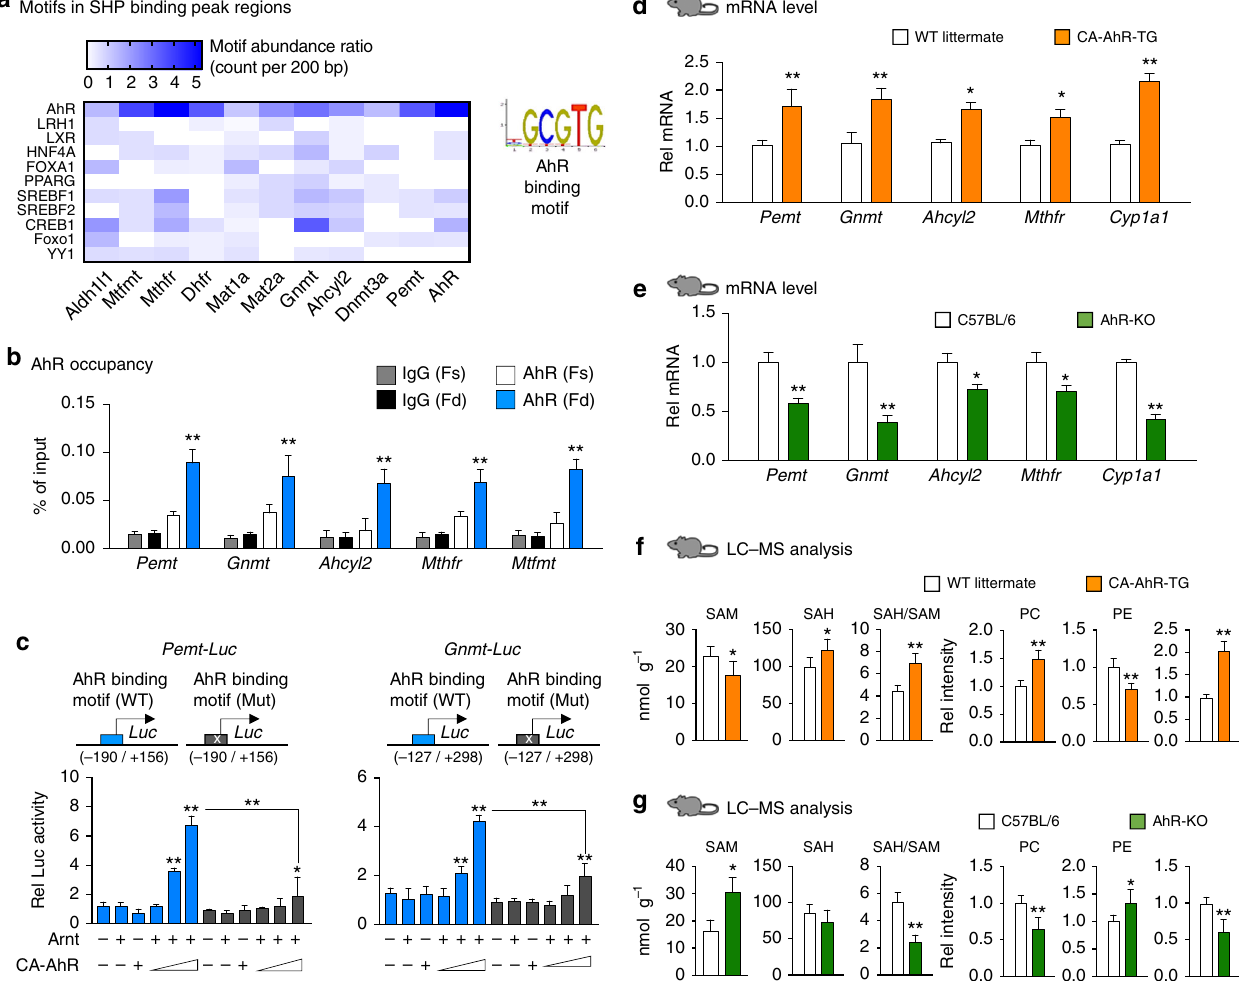
Fig. 3 AhR transactivates 1C cycle genes and increases hepatic PC levels. a Potential binding sites for transcription factors within SHP peak regions at 1C genes were identi fi ed using the JASPAR database, and the abundance of representative factor binding sites is shown (left). An AhR/Arnt binding motif is shown (right). b Mice ( n = 5 mice per group) were fasted overnight (Fs) or fasted and refed for 6 h (Fd), and AhR occupancy within the SHP binding peak regions at the 1C genes was determined by liver ChIP assays. c Hepa1c1c7 cells were transfected with a Pemt-luc or Gnmt-luc construct containing the WT or mutated AhR binding site in the Pemt promoter along with expression plasmids as indicated and treated with FGF19 for 2 h, and luciferase activity was measured ( n = 5). d – g AhR transgenic mouse studies: Liver tissues were collected from WT littermate and CA-AhR transgenic mice ( n = 4 – 7 mice per group), or C57BL/6 (WT control) and AhR-KO mice ( n = 5 – 10 mice per group) and d , e mRNA levels of selected 1C genes and f , g 1C cycle metabolites were measured by qRT-PCR and LC – MS analysis, respectively. Means ± SD are shown, and statistical signi fi cance was measured using d – g Student ’ s t -test or b , c two-way ANOVA with the FDR post-test. * P < 0.05, ** P < 0.01, NS, not statistically signi fi